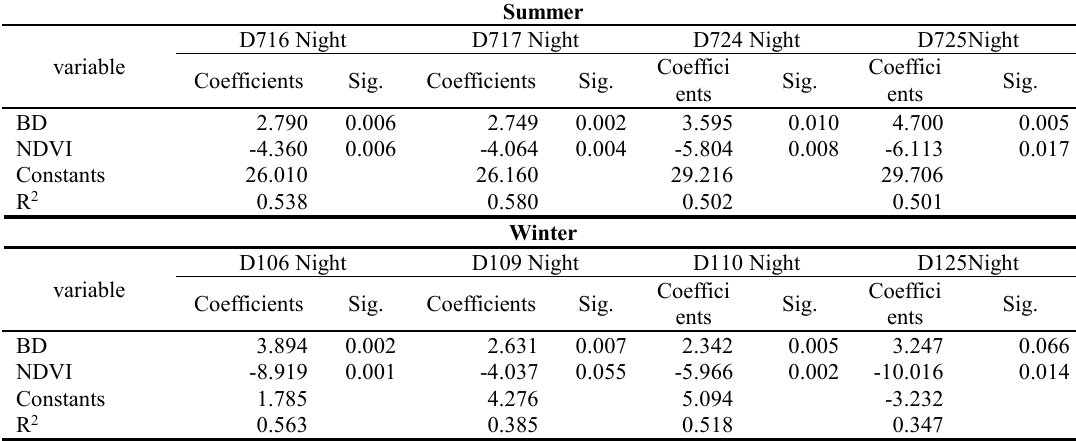
Table 1. Multiple regression results for BD and